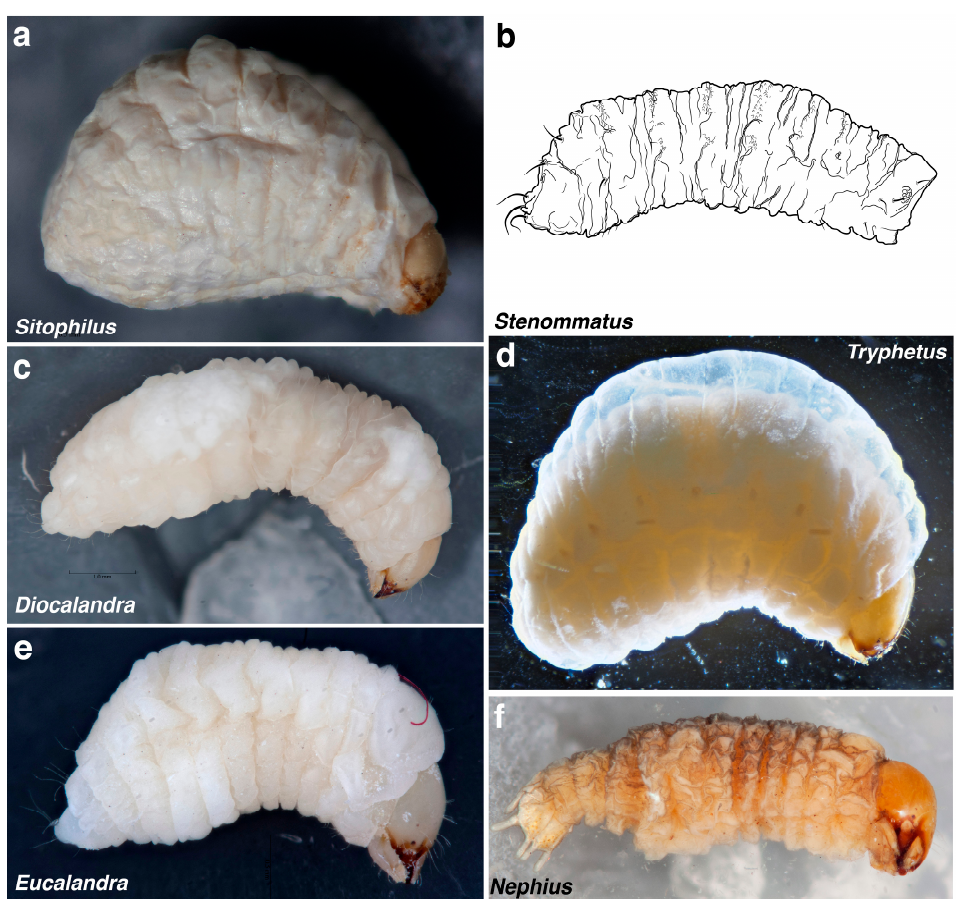
Figure 1. Larva, lateral view: ( a ) Sitophilus ; ( b ) Stenommatus ; ( c ) Diocalandra ; ( d ) Tryphetus ; ( e ) Eucalandra ; and ( f ) Nephius .